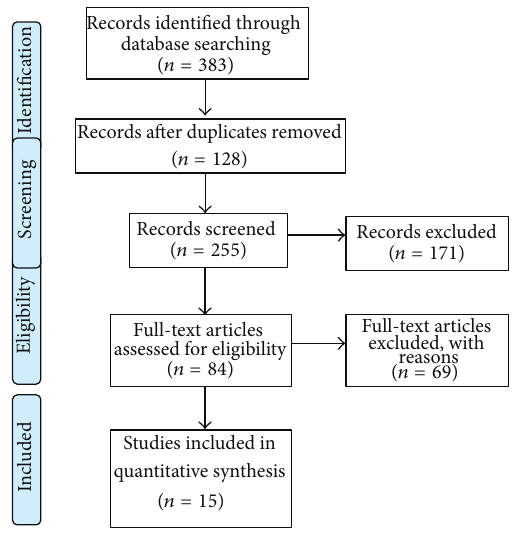
Figure 1: PRISMA 2009 flow